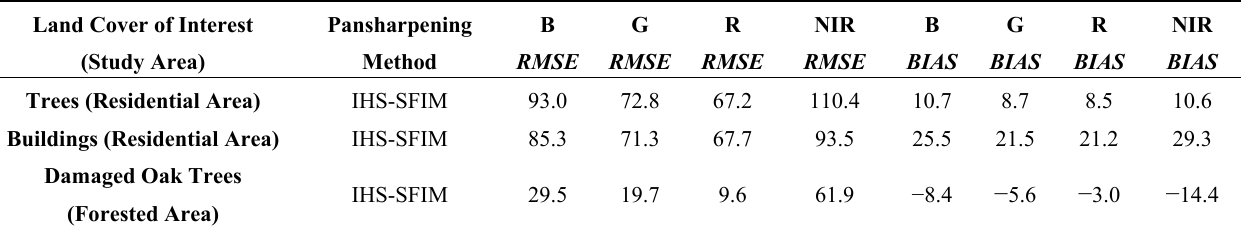
Table 3. RMSE and BIAS of each spectral band using the proposed IHS-SFIM combination approach. The values are similar to those of SFIM in Table 2, and have D Metric values equal to those of IHS in Table